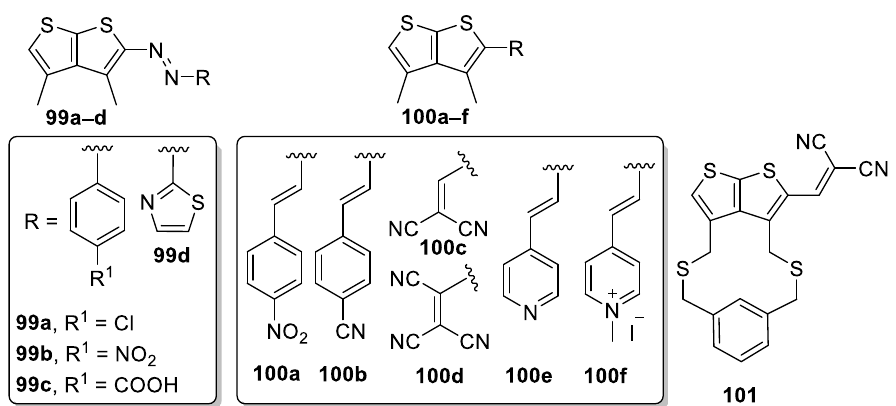
Figure 16. Thieno[2,3- b ]thiophene derivatives 99a – d , 100a – f and 101 with NLO properties. Table 12. The (non)linear optic properties of derivatives 99a – d , 100a – f and 101.